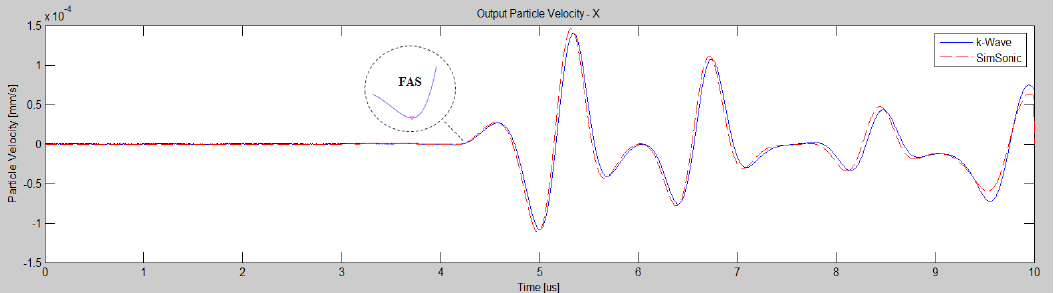
Figure 2. Particle velocity waveforms derived from two different numerical tools, Simsonic and k-Wave, for grid size 20 μm. The threshold for the detection of the FAS is also depicted.